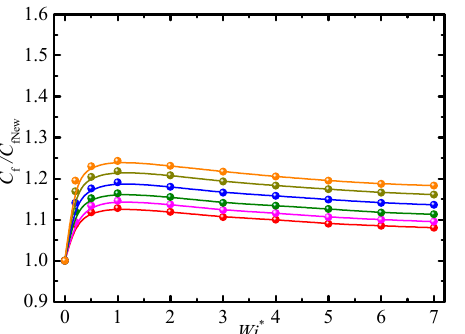
Figure 6. Friction factor vs. modified Weissenberg number for different Reynolds numbers ( β 0 = 0.2, Φ = 1.0%, α = 0.2). ⸺ ● ⸺ : Re = 500; ⸺ ● ⸺ : Re = 100; ⸺ ● ⸺ : Re = 10; ⸺ ● ⸺ : Re = 2.5; ⸺ ● ⸺ : Re = 1; and ⸺ ● ⸺ : Re = 0.5.